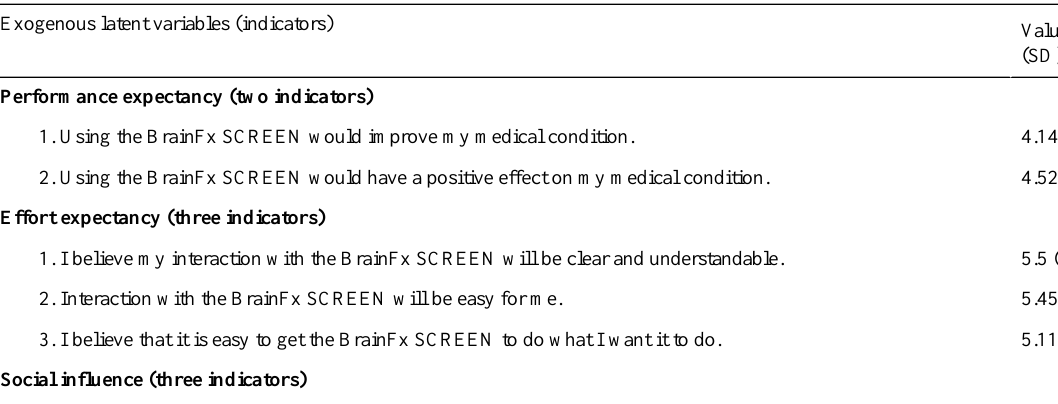
Table 2. Psychometric values of indicator